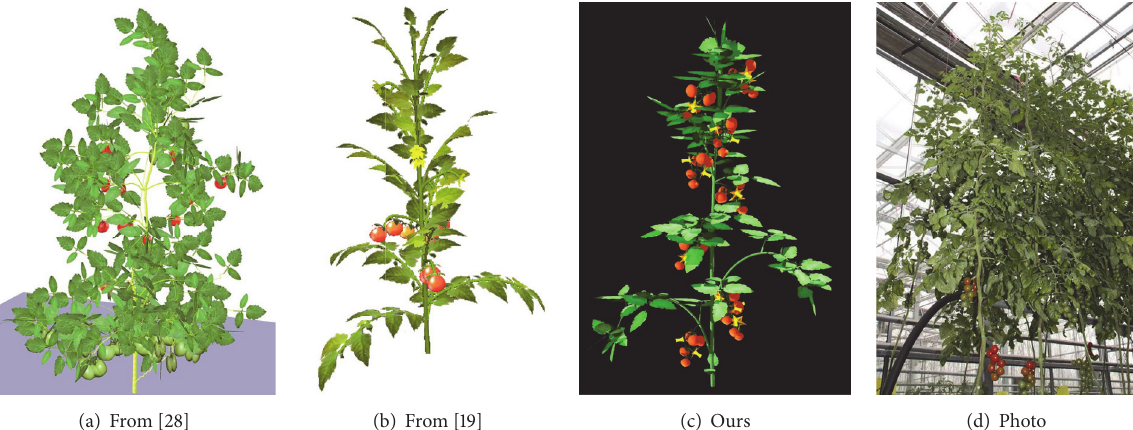
Figure 14: Comparison in the view of visualization.